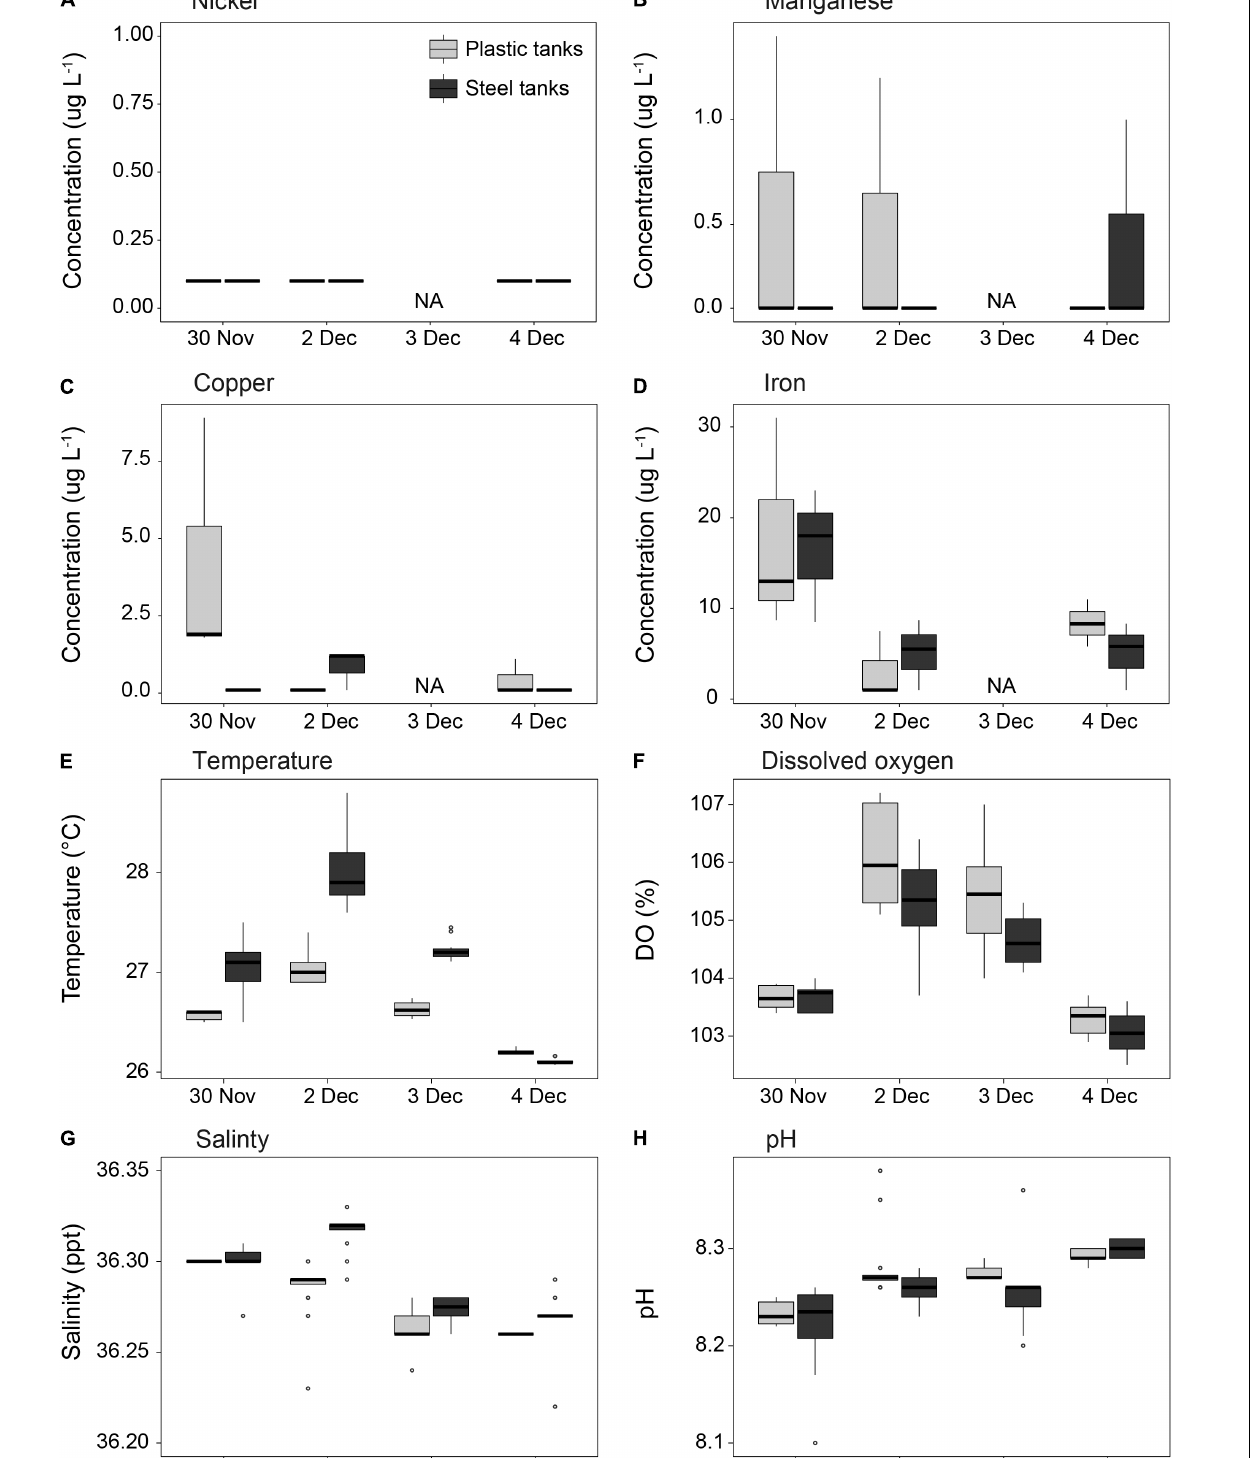
Frontiers in Marine Science |